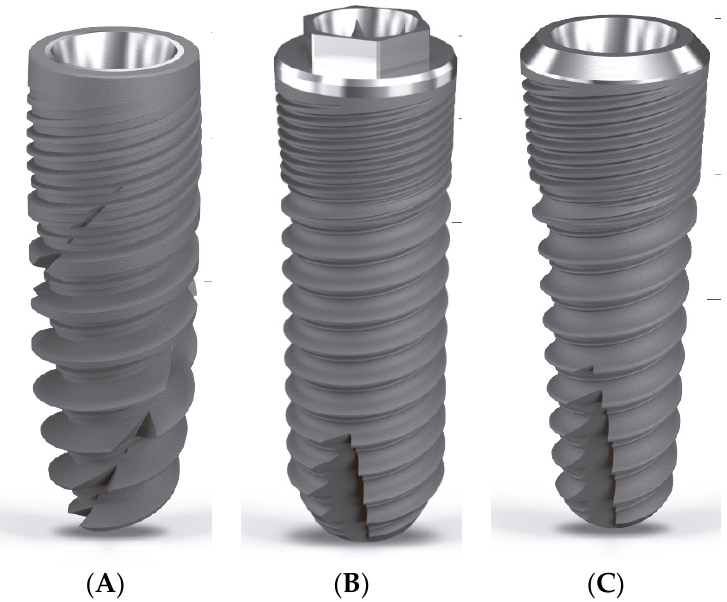
Figure 1. Type of implants. ( A ) Naturactis ® : internal conical connection (ICC) subcrestal-level; ( B ) Uneva ® : external connection (EC) crestal level; ( C ) Naturall ® : ICC crestal level.